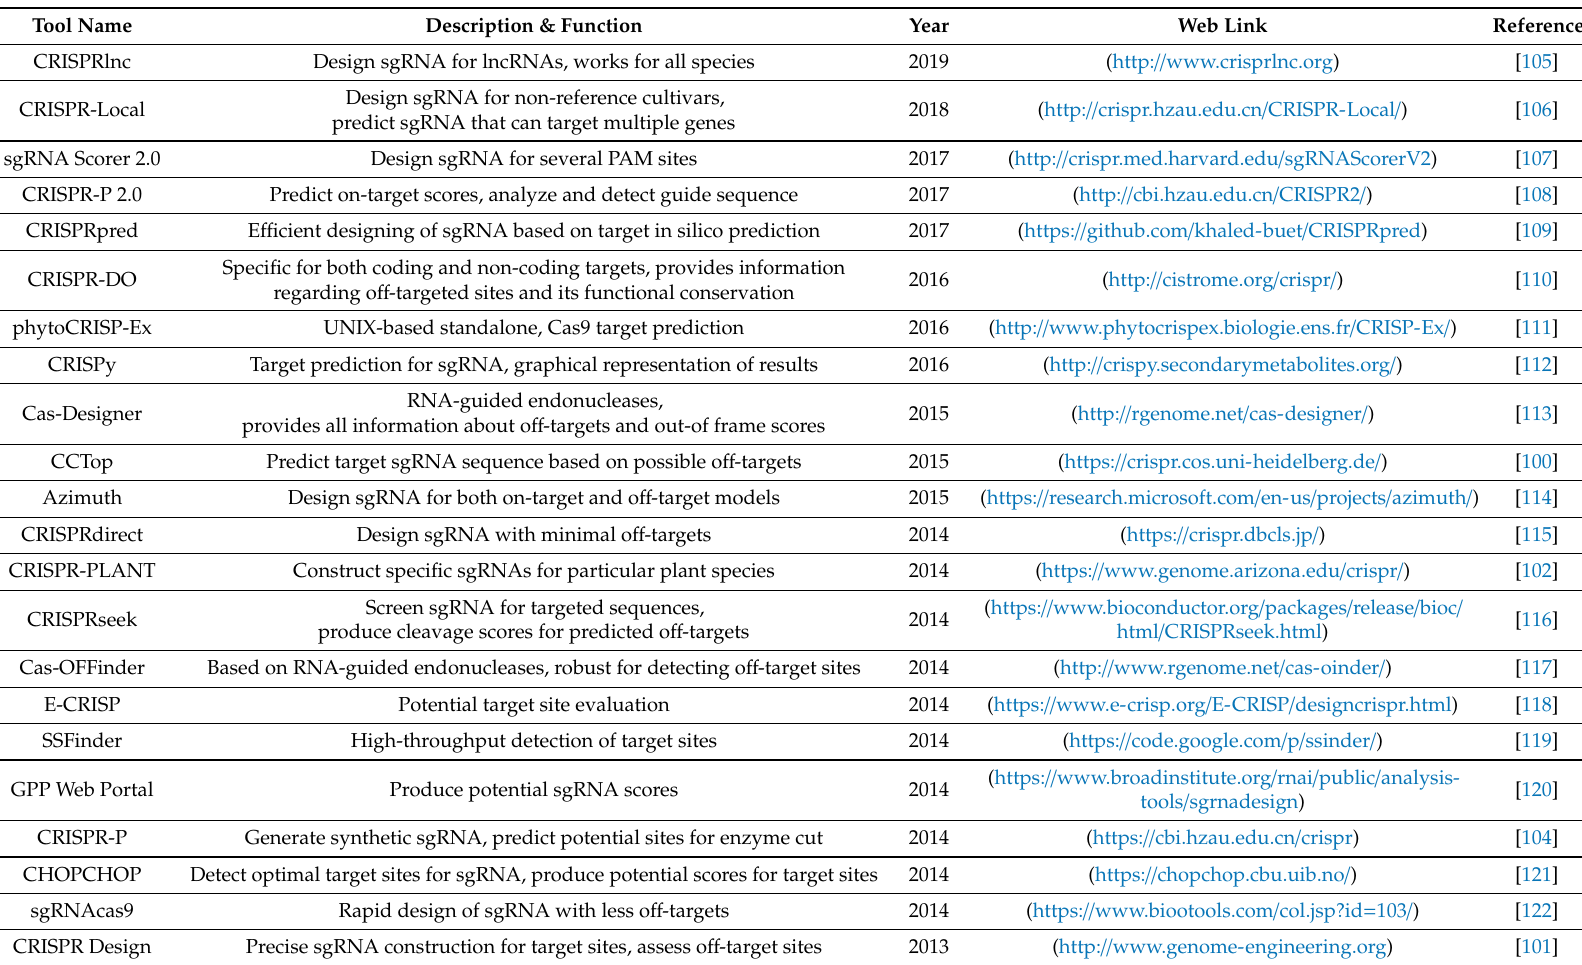
Table 2. List of various single guide RNA (sgRNA) designing bioinformatics tools for the CRISPR / Cas9